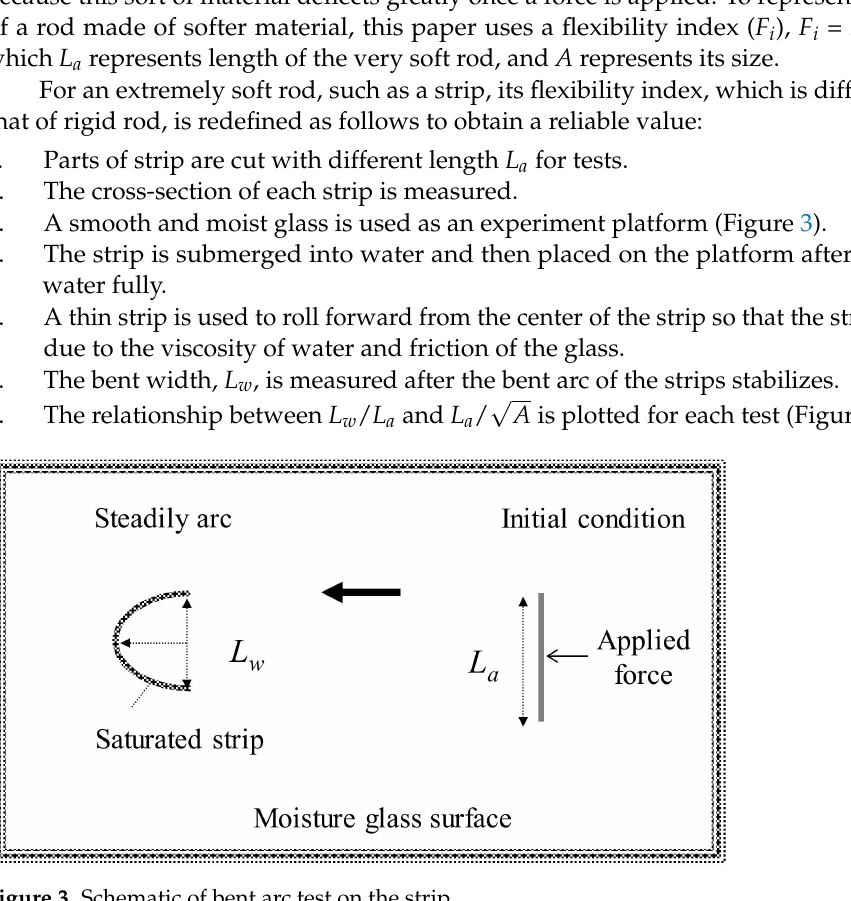
Figure 3. Schematic of bent arc test on the